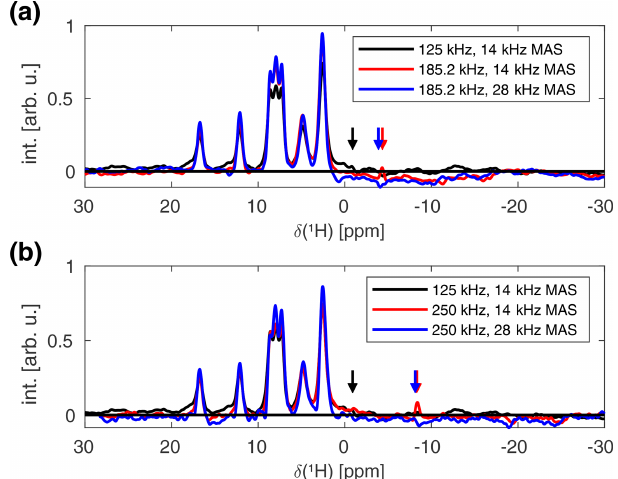
Figure 11. Experimental FSLG decoupled proton spectra of natural-abundance L-histidine recorded at a proton resonance fre- quency of 500MHz, using a 1.9mm Bruker MAS probe. All spectra were recorded using a 2ms I-BURP-2 pulse with a modulation fre- quency of 100kHz (corresponding to the nominal rf field amplitude as determined using a nutation spectrum) for the B 1 selection (Ae- bischer et al., 2020). The effective rf field strength along the magic angle during the FSLG decoupling was set to 125 (a, b) , 185.2 (a) , and 250kHz (b) at MAS frequencies of 14 and 28kHz. The arrows indicate the positions of the carrier frequency. No significant im- provements are observed for stronger B 1 fields and higher spinning frequencies, indicating that the residual linewidth is not decoupling limited.